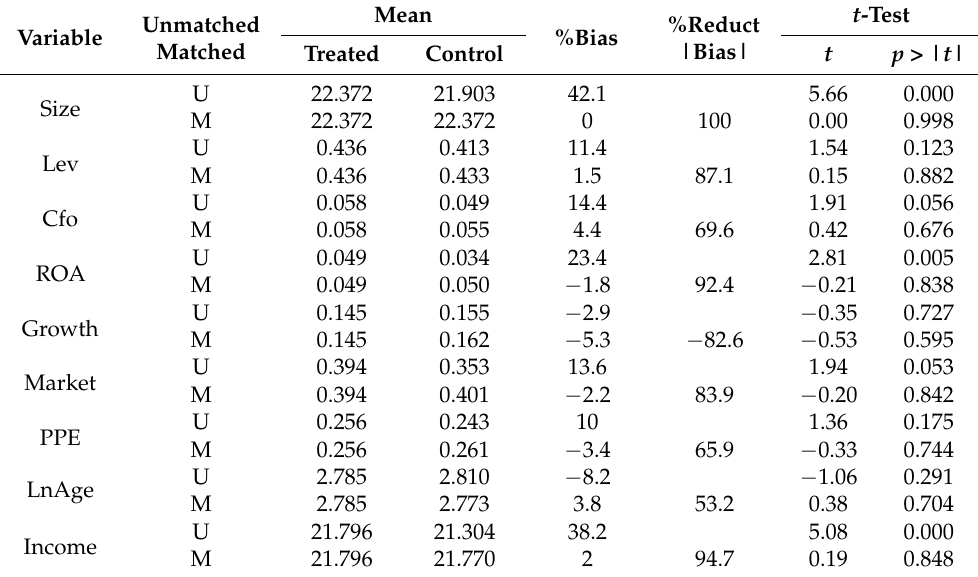
Table 5. Test of covariate